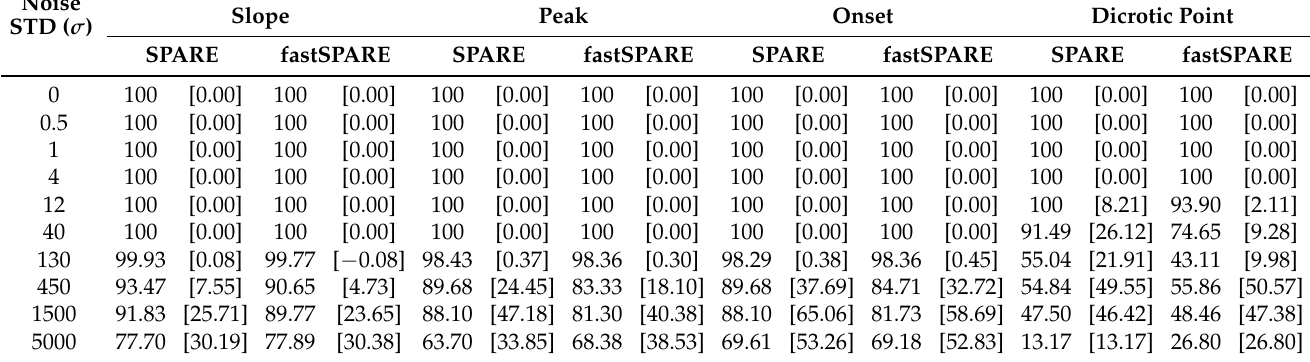
Table 1. Evaluation of SPARE and fastSPARE in terms of geometric mean between sensitivity and specificity for four different fiducial points: slope, peak, onset, and dicrotic point for different noise levels. In brackets, the increment with respect to the same processing pipeline but excluding SPARE (applying the delineation algorithm to the signal after a passband